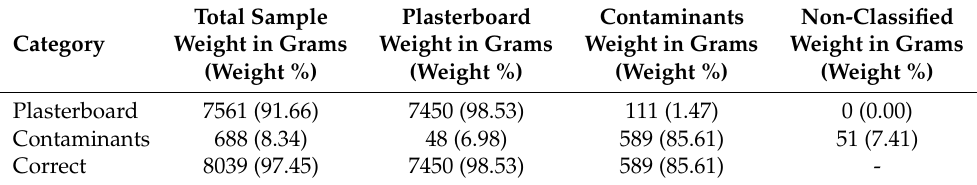
Table 5. Confusion matrix for laboratory-scale refurbishment plasterboard waste